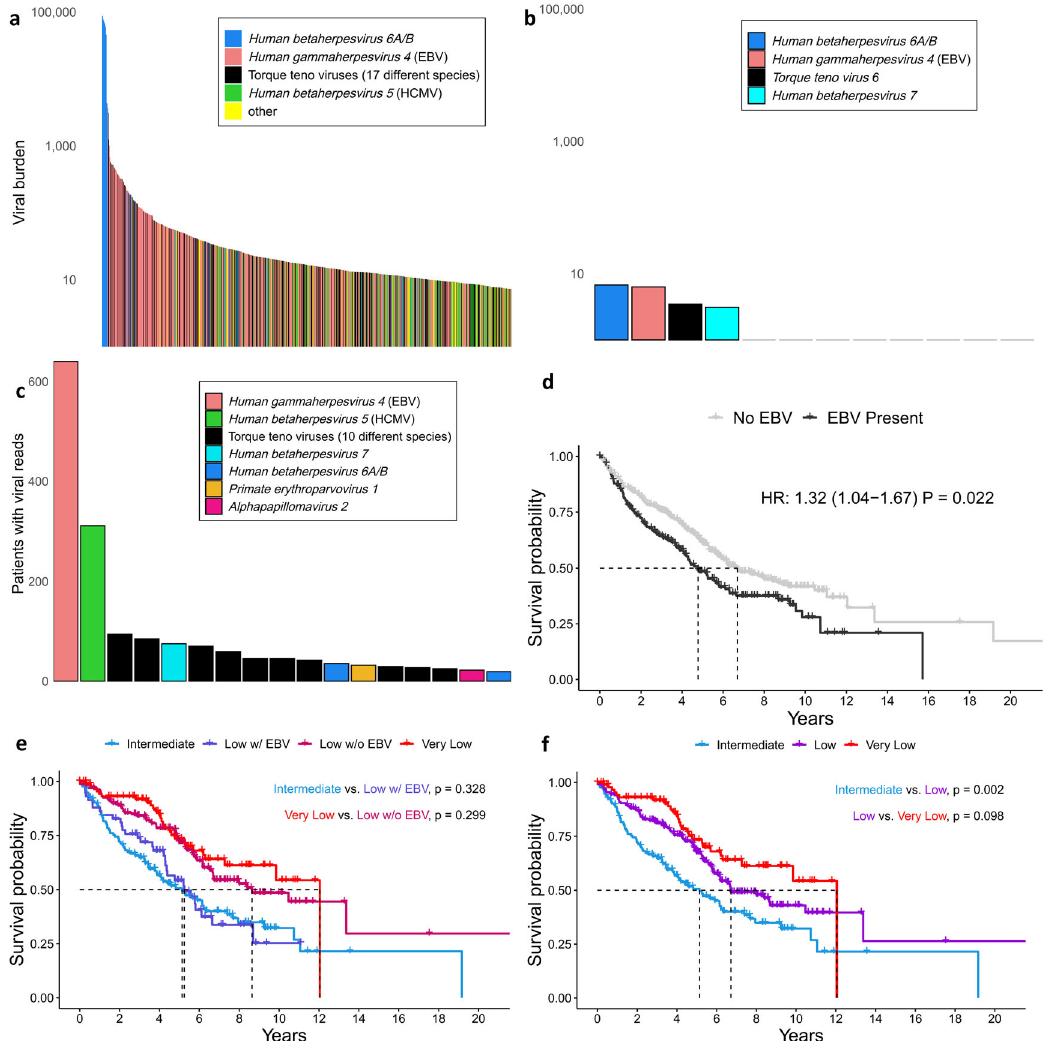
Fig. 2 Circulating viral content is associated with clinical characteristics. a Individual species among the top 1/3 of patients with regard to viral burden. b All controls are shown with their corresponding detected viruses, on the same (logarithmic) scale as panel a , for comparison. Only the leftmost four samples had any detectable viral species. c The prevalence of viral species (those found in >1% of cases are shown). d Presence of EBV (192 patients with EBV, 448 without) is associated with worse survival in MDS patients (HR and P -value are age-adjusted). E The Kaplan – Meier curves for intermediate ( n = 135), low ( n = 224), and very low ( n = 92) IPSS-R categories. f As in panel e , but the low category is strati fi ed by EBV status. Low-risk patients with ( n = 59) and without ( n = 165) EBV become statistically indistinguishable from the intermediate-risk and very low-risk categories, respectively. Two-sided P -values are computed using the Wald test applied to the Cox proportional hazards model. EBV Epstein-Barr virus; HCMV human